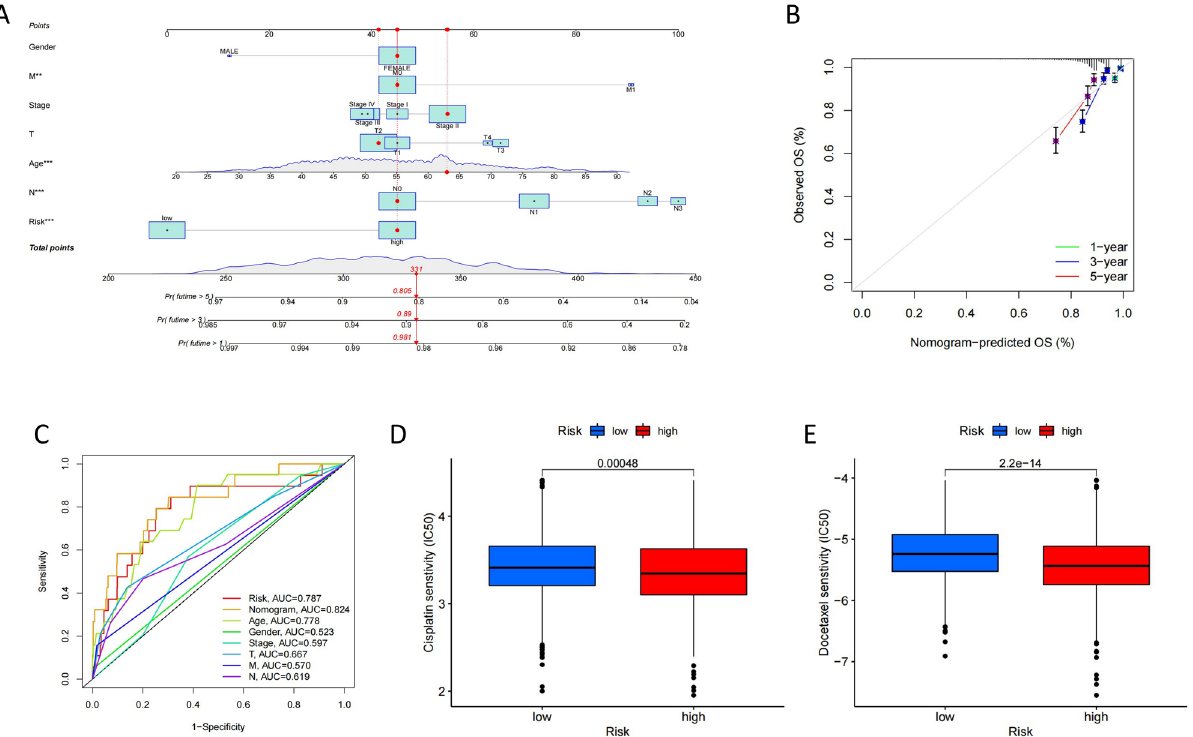
Figure 7. Construction and validation of a nomogram. ( A ) Nomogram for predicting the 1-, 3-, and 5-year OS of BC patients. ( B ) Calibration curves of the nomogram for predicting of 1-, 3-, and 5-year OS in all BC patients. ( C ) ROC curves of risk scores, nomogram and clinicopathological features for all BC patients. ( D,E ) Sensitivity of high and low risk to two chemotherapeutic agents, cisplatin and docetaxel.